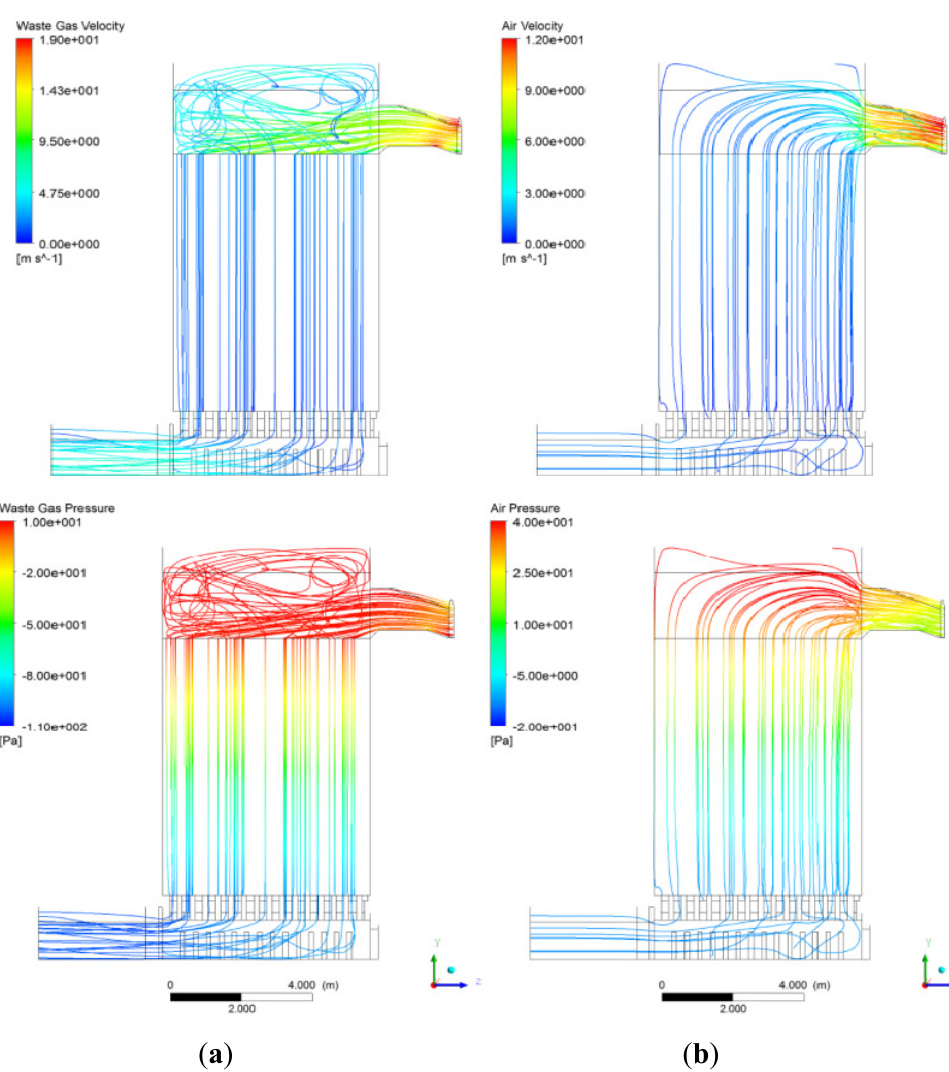
Figure 10. Pressure and velocity streamlines for waste gas ( a ) and air flow ( b ) cycles.